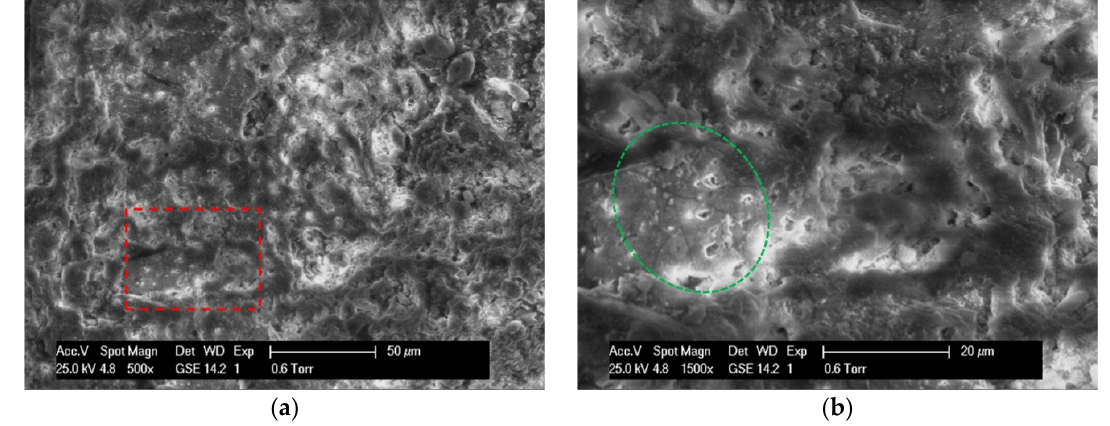
Figure 3. ESEM images: ( a ) Surface of T 5 ; ( b ) Area indicated in (a) at higher magnification.